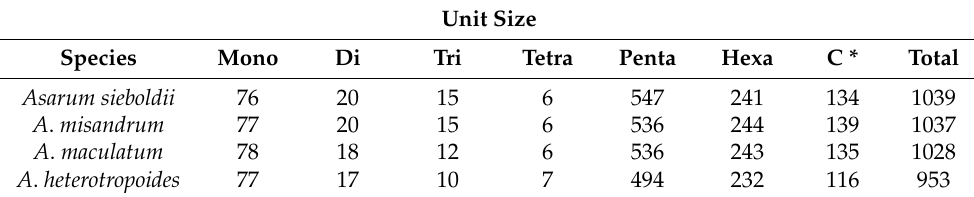
Table 3. The distribution and number of simple sequence repeats (SSRs) in four Korean Asarum